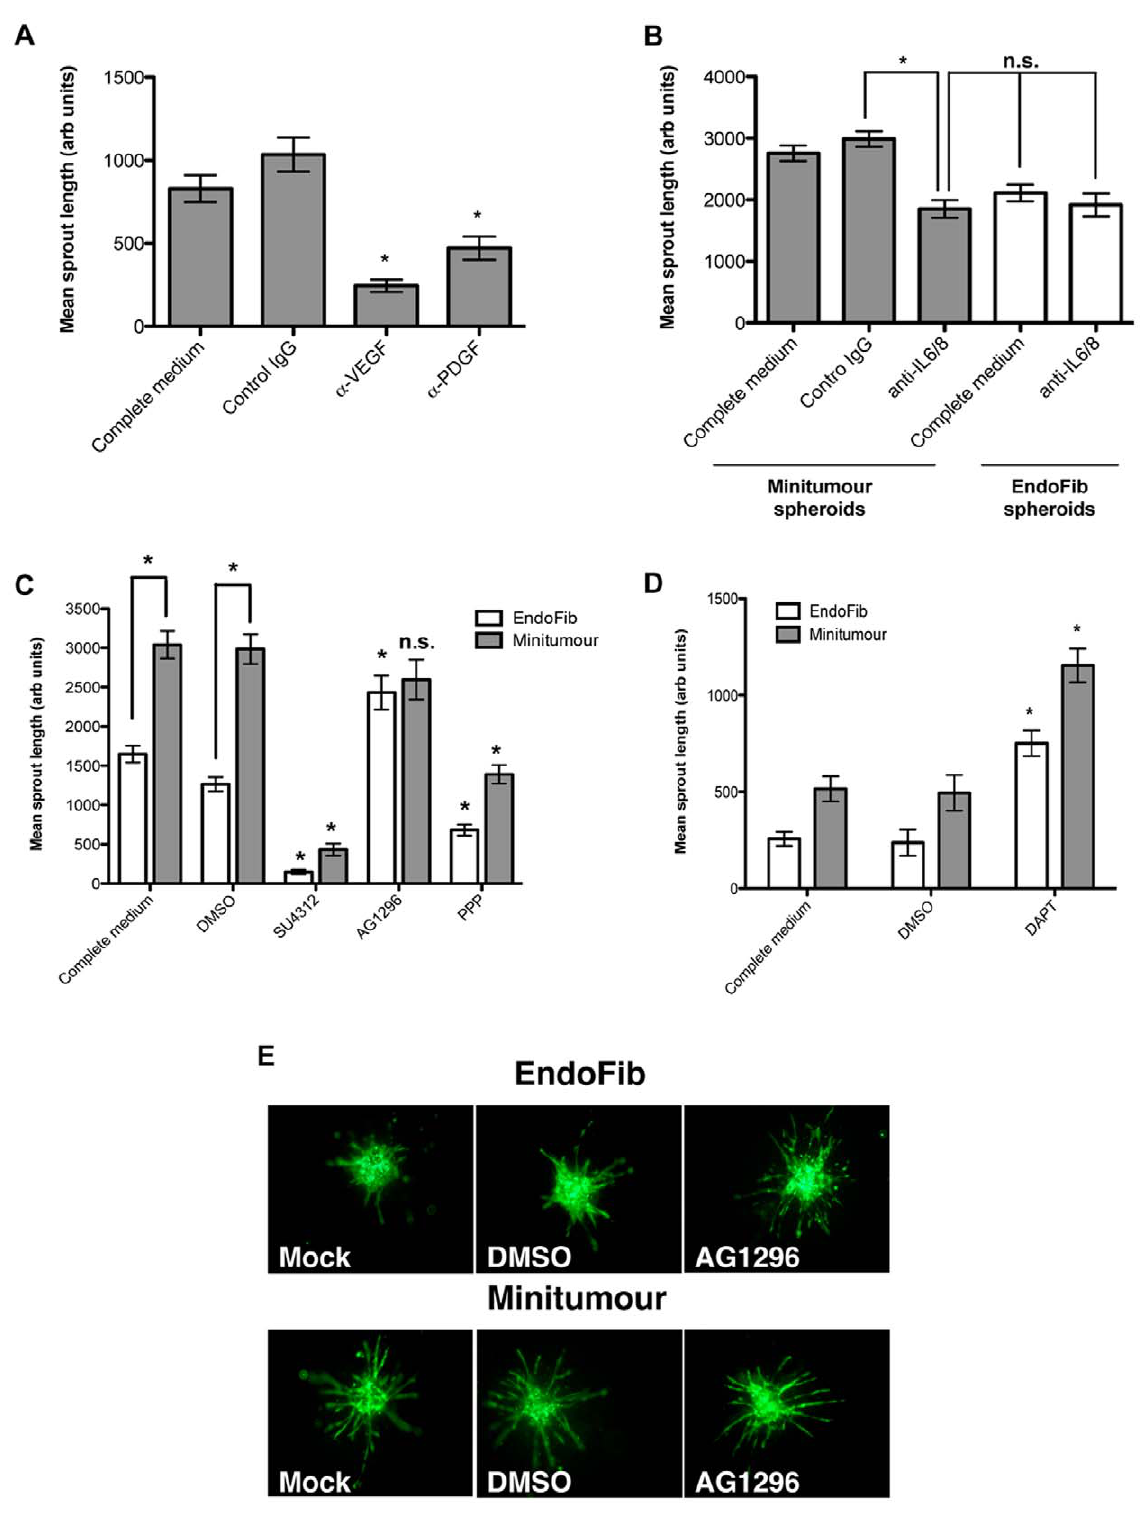
Figure 4. Minitumour spheroids growth factor dependency. A – Direct incubation of function blocking antibodies for VEGF or PDGF within the collagen-I gel decreases endothelial cell sprouting from the Minitumour spheroids. B – Minitumour spheroids incubated with function blocking antibodies to IL6 and IL8 show similar levels of sprout formation to EndoFib spheroids. C - Minitumour and EndoFib spheroids show a differential response to inhibition of growth factor signaling using small molecule growth factor receptor inhibitors. D – Increase in endothelial cell sprouting in both Minitumour and EndoFib spheroids after 40 h incubation with the gamma-secretase inhibitor DAPT. E – Representative images from Minitumour and EndoFib spheroids incubated in collagen-I for 40 h with the addition of different growth factor receptor inhibitors.